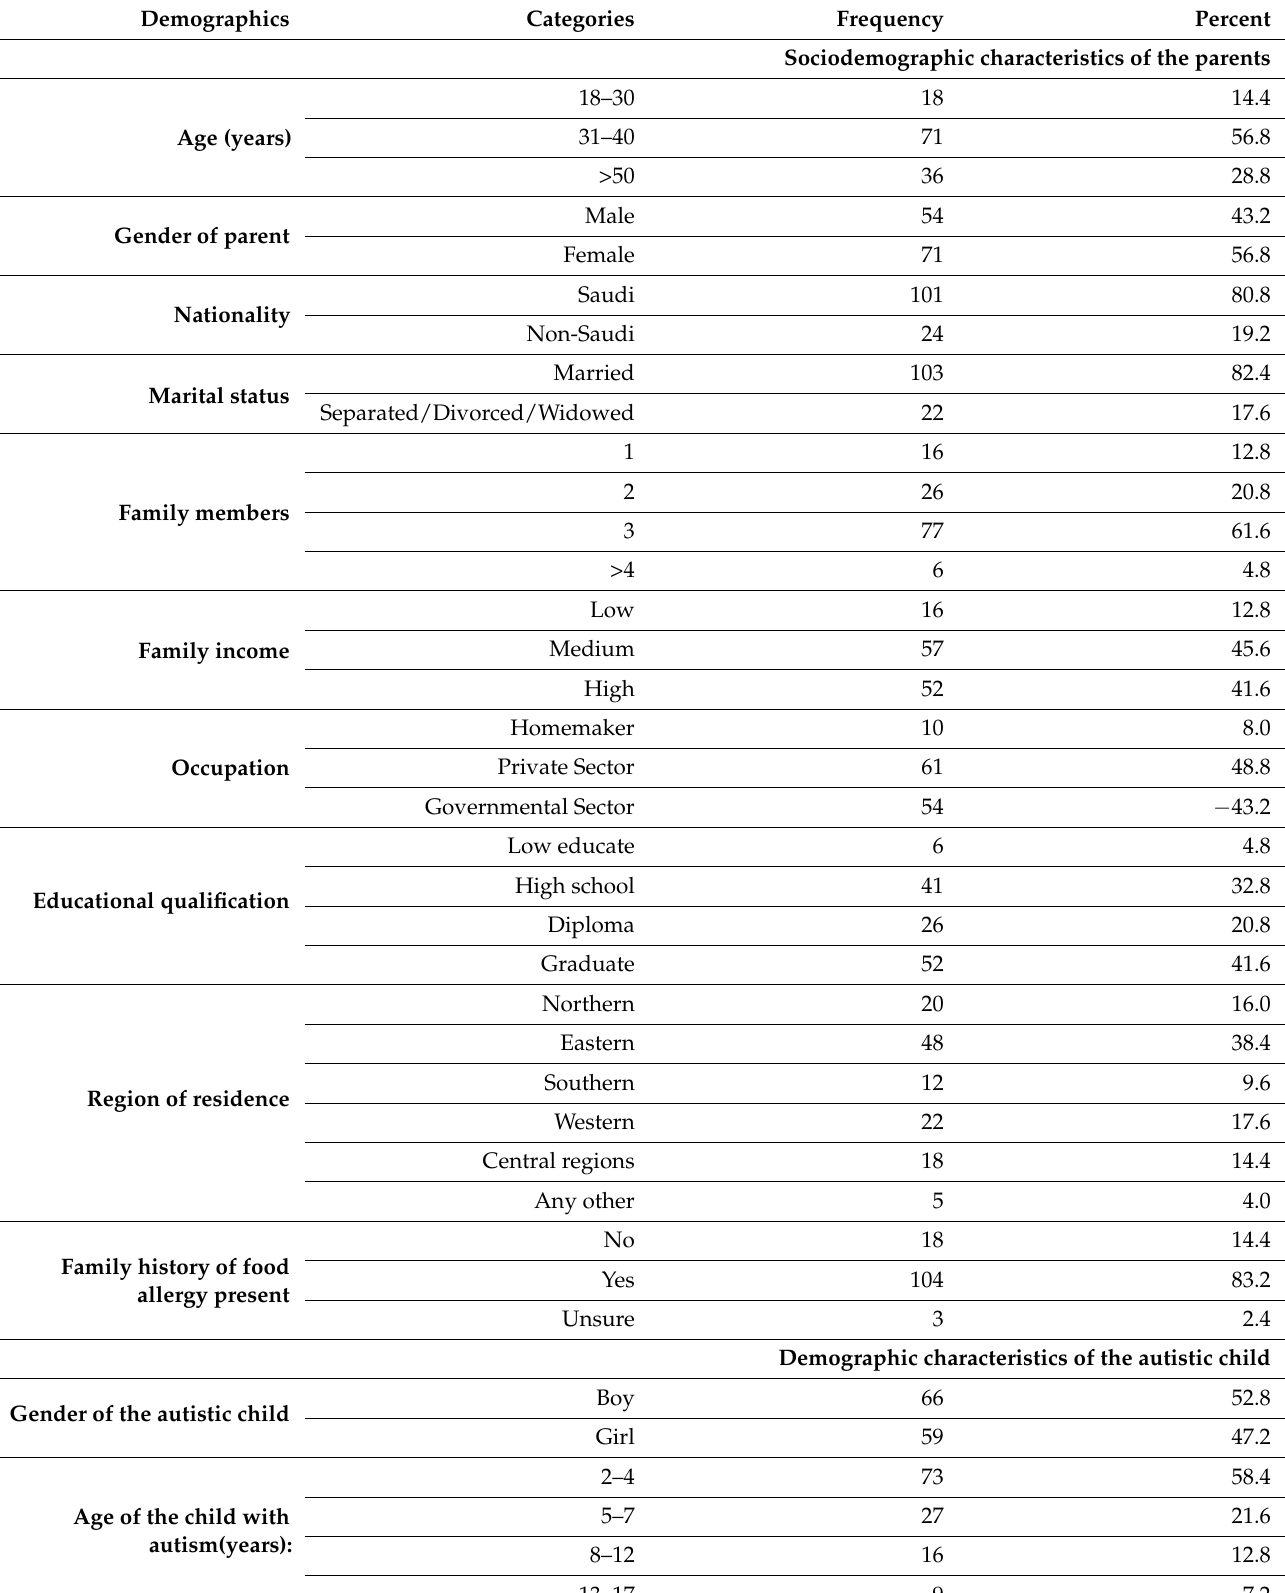
Table 1. Characteristics of the participating parents and